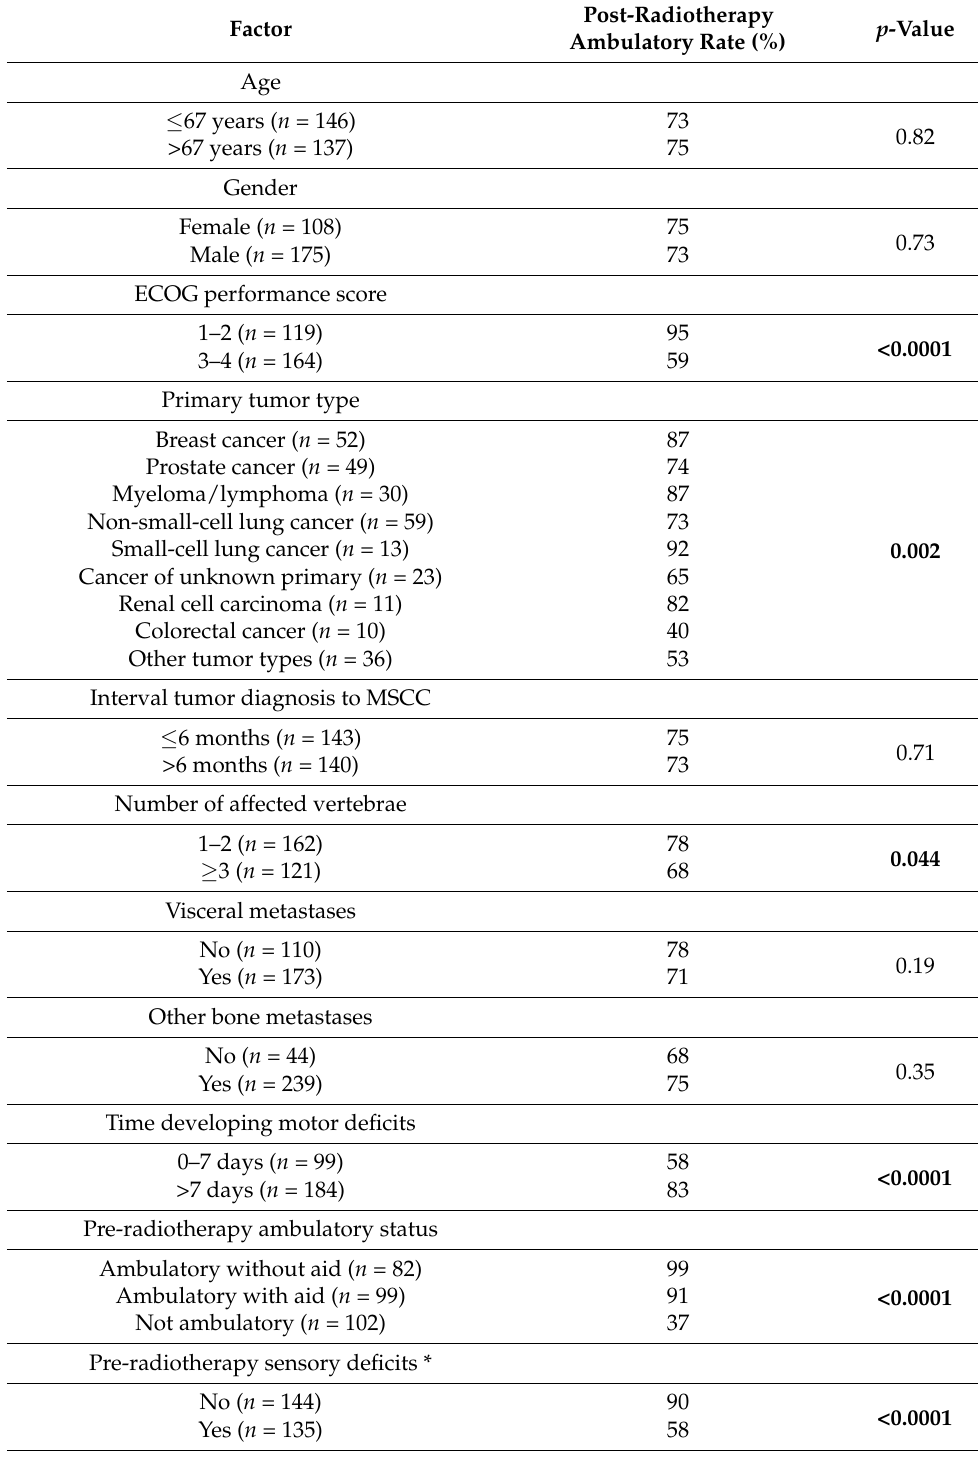
Table 1. Univariable analyses: Ambulatory rates following radiotherapy. The p -values were obtained using the Chi-square